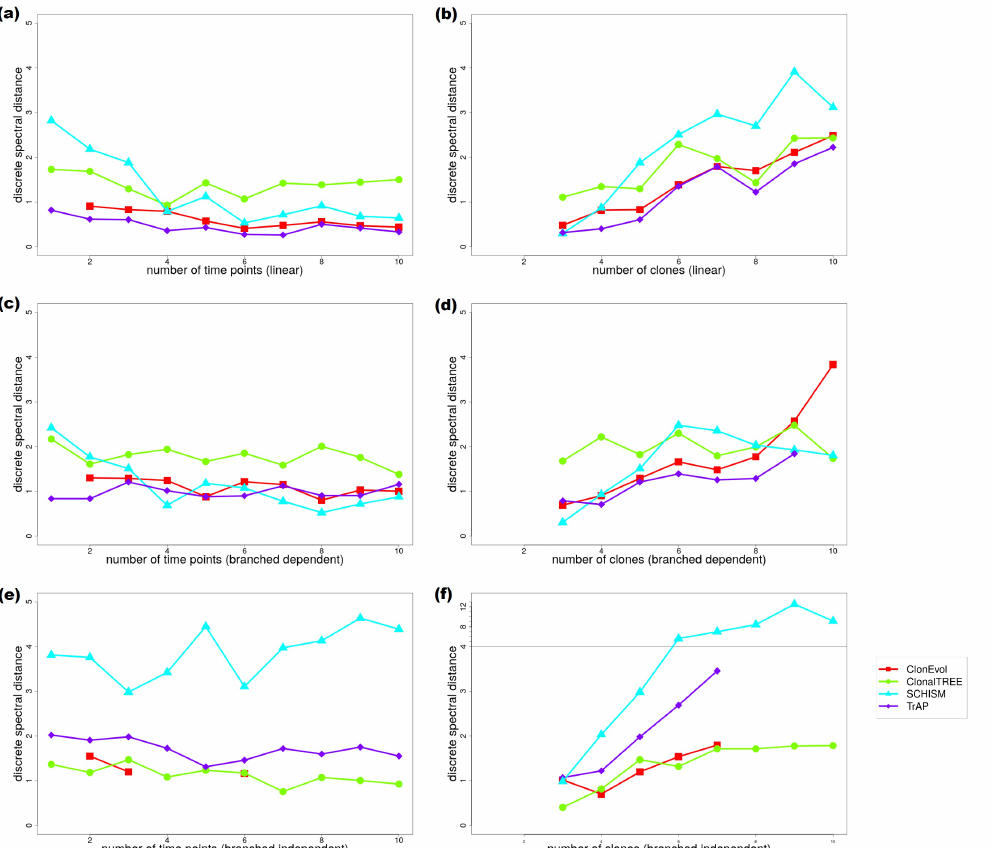
Figure 5. Discrete spectral distance comparing the trees reconstructed usinh ClonEvol, ClonalTREE, SCHISM, and TrAP to simulated truth. If tools report more than one tree, the average distance over all reported trees is calculated. We evaluate the influence of varying ( a ) number of time points at linear evolution; ( b ) number of clones at linear evolution; ( c ) number of time points at branched dependent evolution; ( d ) number of clones at branched dependent evolution; ( e ) number of time points at branched independent evolution; and ( f ) number of clones at branched independent evolution. Of note, branched dependent and independent evolution can only be considered in the presence of ≥ 3 clones. A missing dot indicates missing clustering results for all 10 patients per simulated data